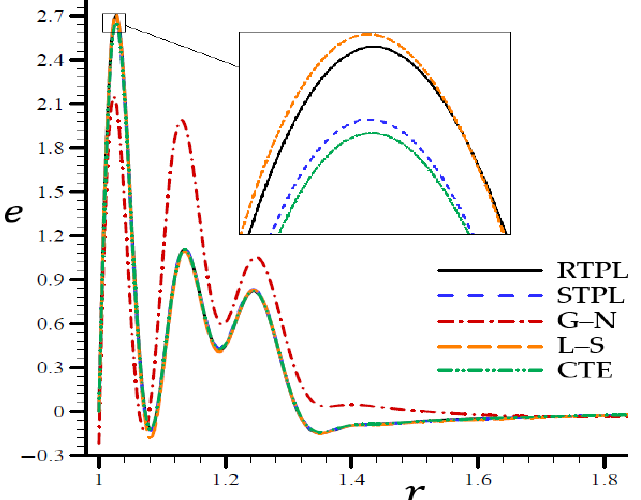
Figure 3. The volumetric strain 𝑒 through the radial direction of the spherical hole for all models. According to the STPL, L – S, and CTE models in Figure 3, the 𝑒 values follow the RTPL theory ’ s vibrational trajectory exactly. This model ’ s trajectory varies concerning the G – N model ’ s values of 𝑒 . There was a noticeable shift in the 𝑒 values after 𝑟 = 1.68 , after which the values were similar to each other. In Figure 4, the CTE and STPL models have radial displacements 𝑢 potentially identical to that of the RTPL model, which vanished in the direction of the radial motion. To put it another way, the G – N and L – S models ’ displacements 𝑢 may represent upper or lower limitations on the values produced by the RTPL model. Figure 4. The radial displacement 𝑢 through the radial direction of the spherical hole for all models.